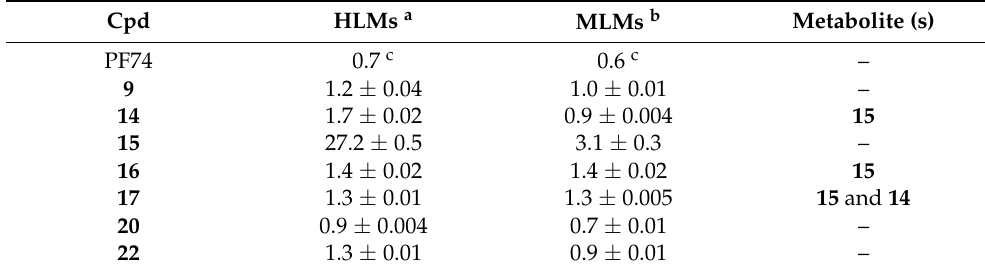
Table 4. Phase I metabolic stability in liver microsomes t 1/2